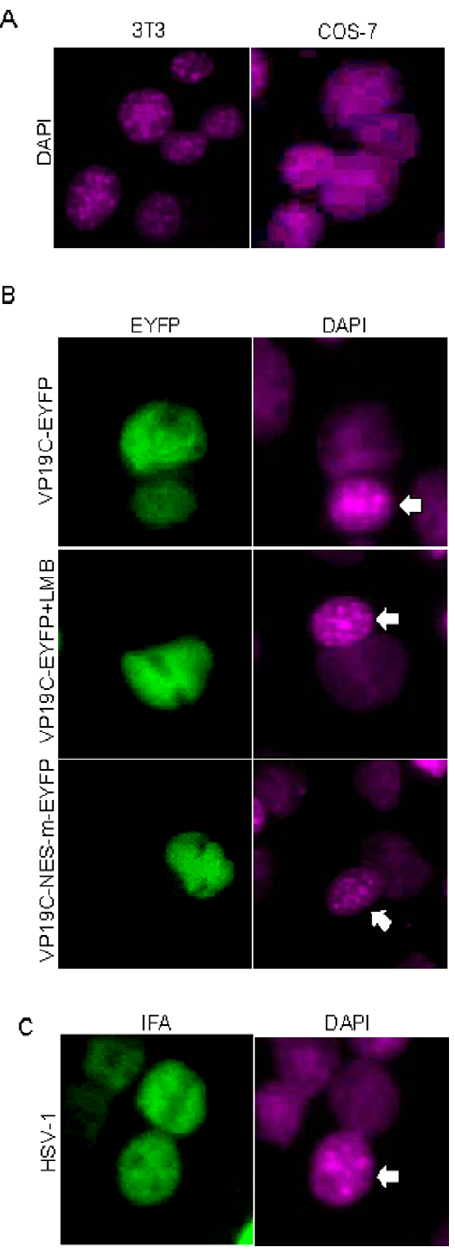
Figure 2. Nucleocytoplasmic shuttling of VP19C. ( A ) DAPI staining differentiates monkey (COS-7) and murine (3T3) nuclei. (B) Nucleocytoplasmic shuttling of VP19C via a leucine-rich NES: COS-7 cells were transfected with plasmid VP19C-EYFP or VP19C NES-m-EYFP. 24 hours later, transfected cells were subjected to the interspecies heterokaryon assay. Mouse 3T3 cells were identified by their speckled nuclei when stained with DAPI. (C) Nucleocytoplasmic shuttling of VP19C during HSV-1 infection. COS-7 cells were firstly infected with HSV-1 at MOI of 2. At 12 hour after infection, the HSV-1 infected COS-7 cells were mixed with 3T3 cells and subjected to the heterokaryon assay. Mouse 3T3 cells were identified by their speckled nuclei when stained with DAPI. Each image is representative of the vast majority of the cells observed.